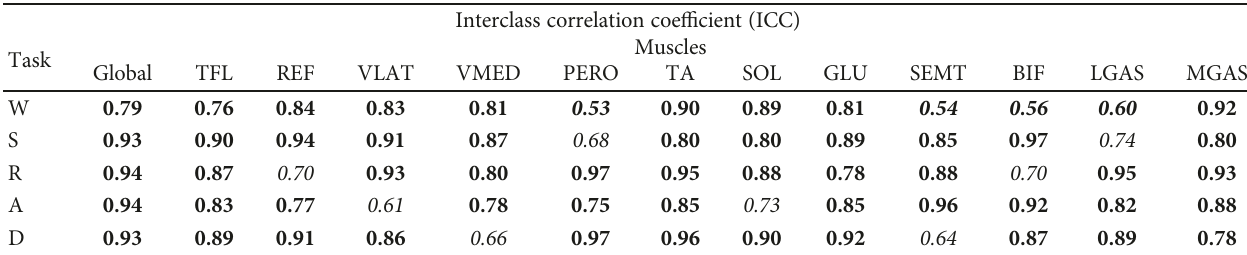
Table 3: Maximum and minimum and related standard deviation (SD) of the WW VAF WW VAF glo Task (%)